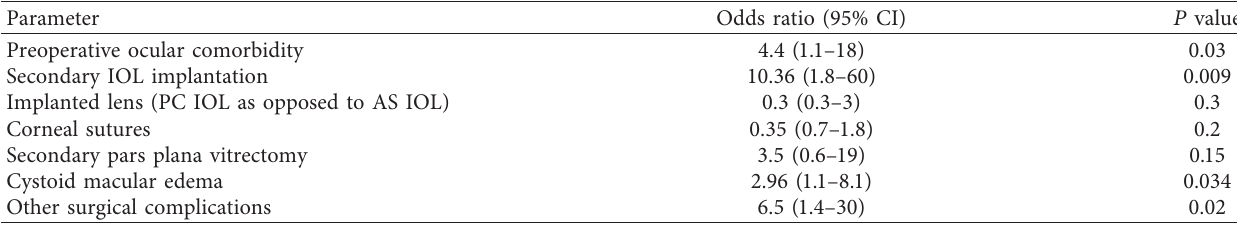
Table 3: Multivariable analysis potential parameters associated with low visual outcome.